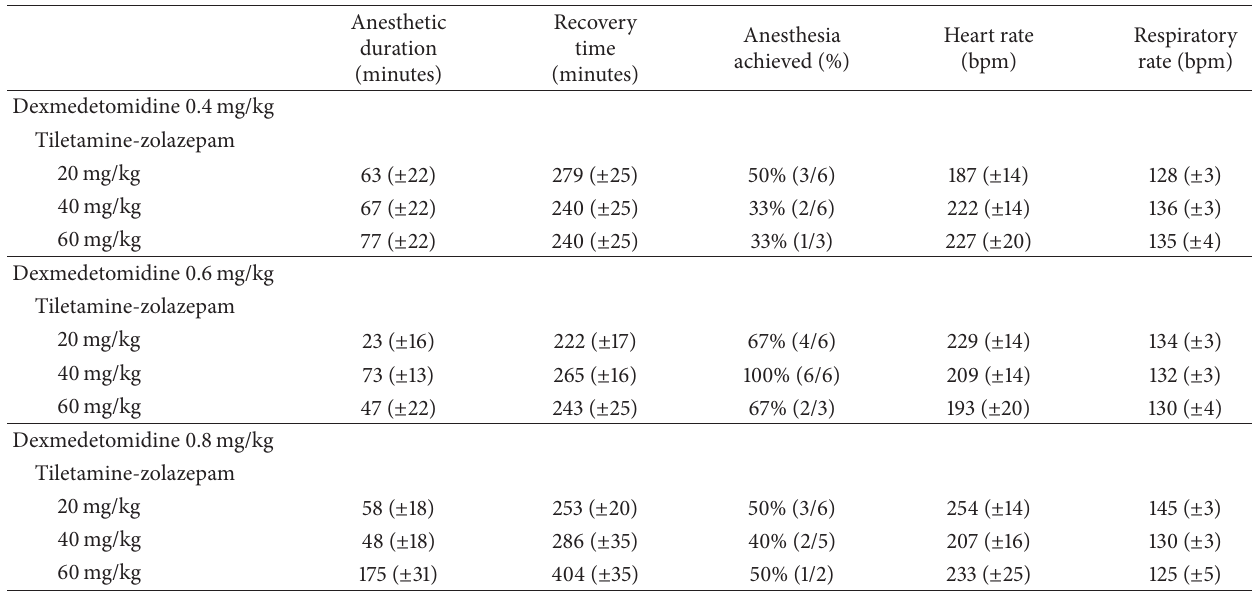
Table 2: Trials with dexmedetomidine and tiletamine-zolazepam (DTZ). Dexmedetomidine and tiletamine-zolazepam were administered IP and butorphanol was administered at 3 mg/kg SC. Data is reported in marginal means and standard error. Anesthetic duration (minutes)